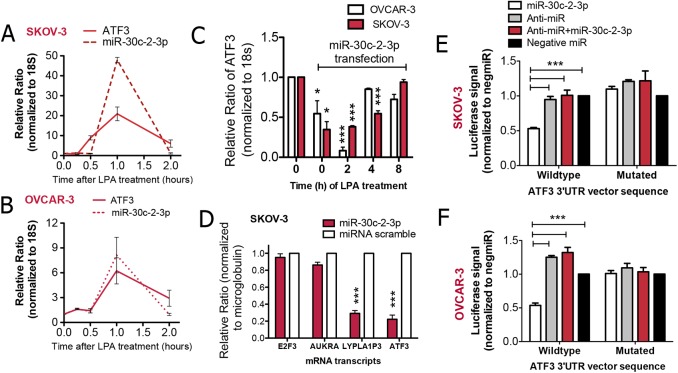
MiR-30c-2-3p inhibits ATF3 expression.(A) SKOV-3 or (B) OVCAR-3 cells were treated with lysophosphatidic acid (LPA, 5 μM) for 0.5, 1 or 2 h prior to the assessment of ATF3 and miR-30c-2-3p expression. The data is presented as a line graph of the relative ratio. (C) Cells were transfected with miRNA scramble or miR-30c-2-3p for 24 h prior to treatment with lysophosphatidic acid (LPA, 5 μM) for the times indicated and assessment of ATF3 expression. The bar graph shows the average relative ratio normalized to a housekeeping control. ***p<0.001, *p<0.05 (D) SKOV-3 cells were transfected with miR-30c-2-3p or a scramble miRNA control for 48 h prior to the quantification of mRNA transcripts. (E) SKOV-3 or (F) OVCAR-3 cells stably expressing an ATF3 3´UTR encoded luciferase vector (wild type) or a vector with mutations in the 3´UTR sequence (mutated) were transfected with either miR-30c-2-3p, anti-miR-30c-2-3p (anti-miR), miR-30c-2-3p + anti-miR-30c-2-3p or a control (negative-target miRNA) for 48 h prior to luciferase signal intensity measurement. ***p<0.001.